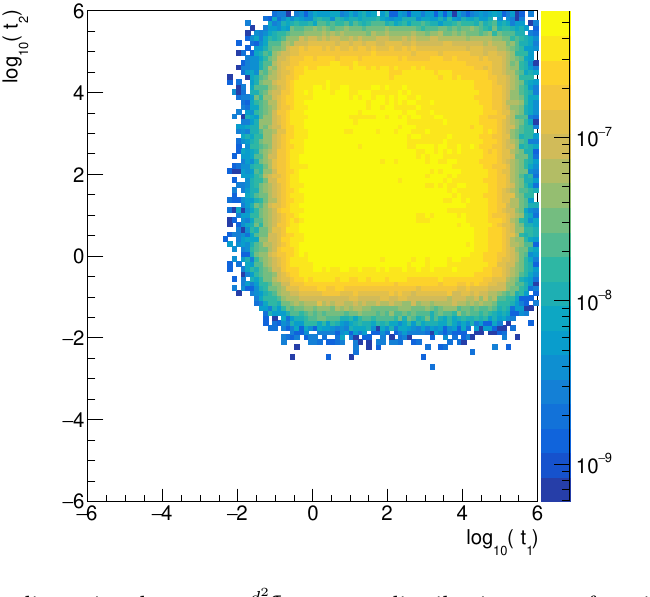
Figure 7 . The two-dimensional d 2 (cid:27) log 10 ( (cid:0) t 2 ) in nb for the inelastic-inelastic contribution. Here Q 2